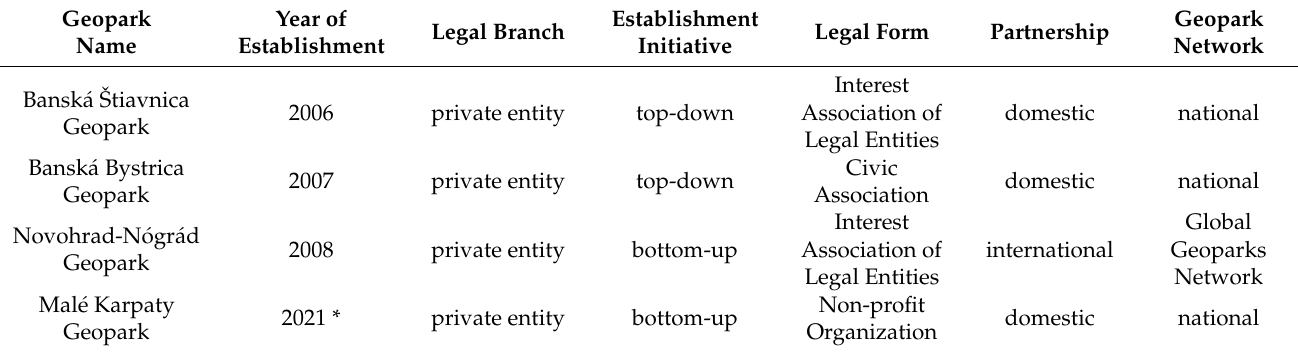
Table 1. Overview of geoparks operated in